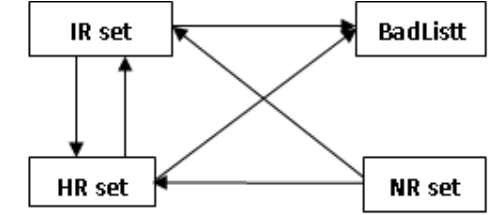
Fig. 2. The transition among entity’s HR set, IR set NR set and